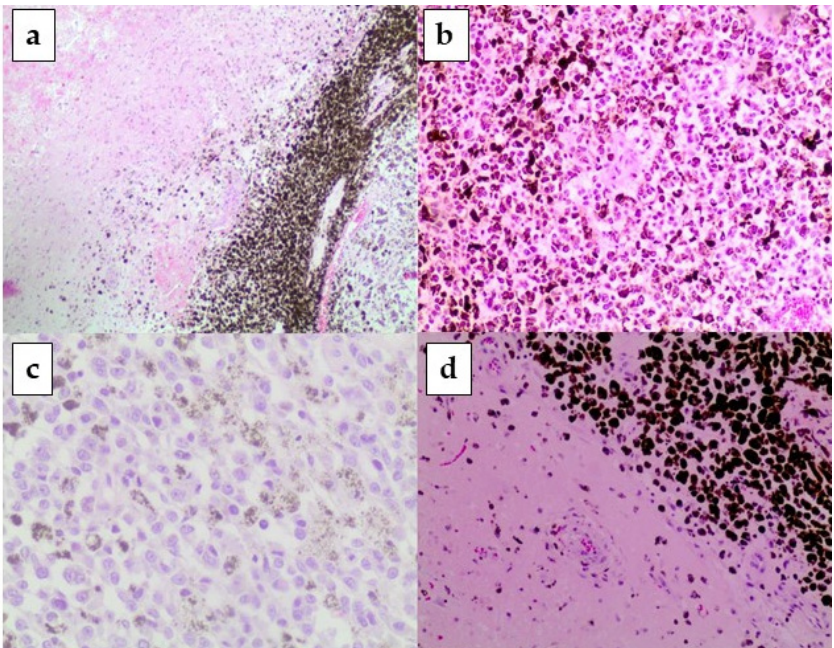
Figure 5. Histological findings. ( a ) neoplastic voluminous cells with melanin in the cerebral tissue (E.E. 60×); ( b ) neoplastic cell population: numerous, voluminous melanoblasts with marked nuclear pleiomorphism; ( c ) neoplastic cells with melanic pigment antimelanoma-antibody (HMB45 + 200×); ( d ) neoplastic cell population near a small cerebral artery (E.E. 200×).